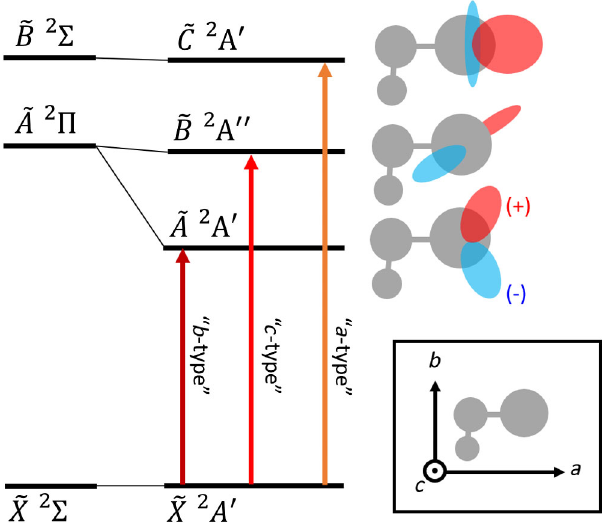
FIG. 3. Representative energy-level diagram for species of C symmetry relevant to the present work, including correlations between linear (left) and asymmetric top (right) states. The asymmetry of the molecule leads to a splitting of the 2 Π potential, lifting the degeneracy of the in-plane and out-of-plane orbitals. The diagram is essentially the same, aside from symmetry labeling, for other highly ionic doublet species. Optical transi- tions are labeled by the dominant transition dipole moment component. Schematic drawings of the orientation of the electron density are included to rationalize these assignments. Red and blue are the phase of the electronic wave function. Inset: Principal axis system for the example species.